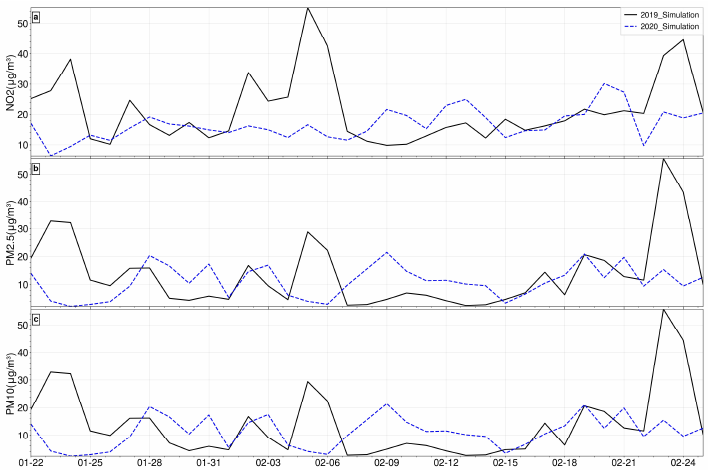
Figure 10. Daily average concentrations ( µ g/m 3 ) of traffic emissions of NO 2 ( a ), PM 2.5 ( b ), and PM 10 ( c ) in Nanjing during the NP and LP.